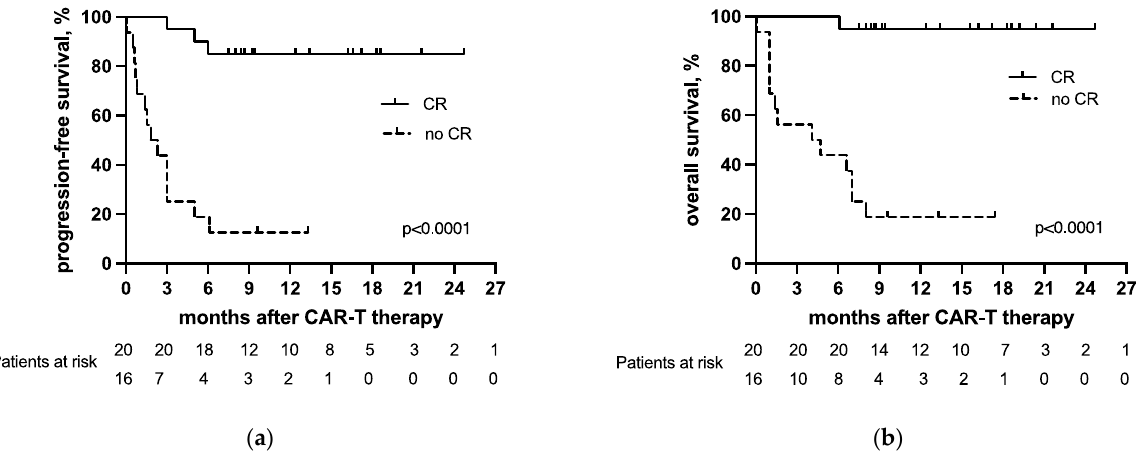
Figure 2. ( a ) Progression ‐ free survival and ( b ) overall survival of the patients who did and did not achieve complete remission as a best response after CAR ‐ T ‐ cell therapy. The kinetics of the CAR ‐ T ‐ cell ‐ specific DNA in the peripheral blood of the CAR ‐ T ‐ cell recipients were monitored by ddPCR. The median time to reach the peak concentra ‐ tion of the CAR ‐ T ‐ cell ‐ specific DNA in the peripheral blood after the CAR ‐ T ‐ cell infusion